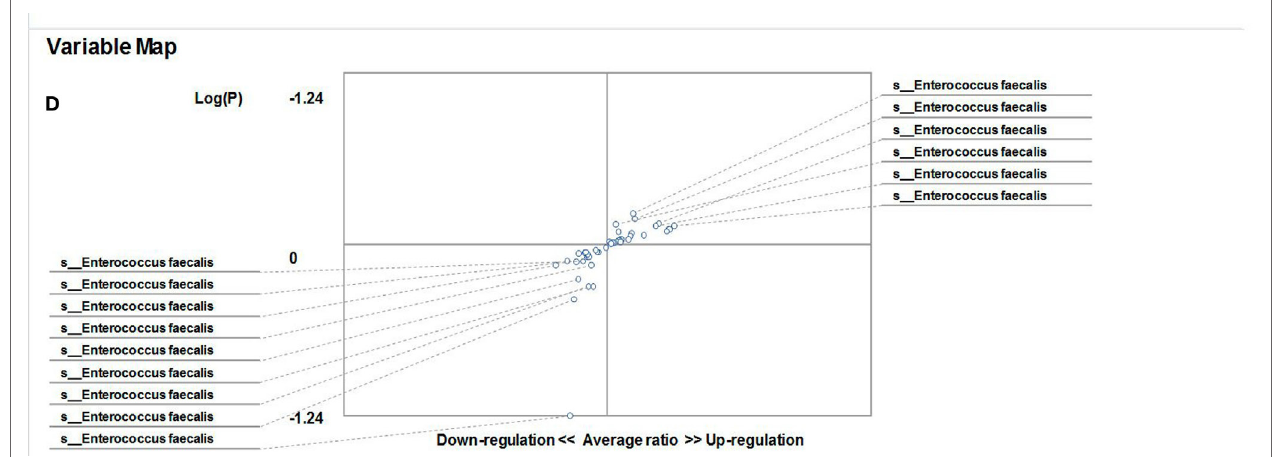
FigUre 5 | Distribution of gut Enterococcus faecalis in familial Mediterranean fever (FMF) men. Contribution of variables to differentiation between two groups [ X axis, average ratio between two groups; Y axis, − Log (P)]. The upper-right and lower-left corner are the most significant. (a) FMF men with Candida albicans below baseline level/healthy men; (b) FMF men with gut C. albicans numbers above baseline level after probiotic therapy/healthy men; (c) FMF men with gut C. albicans numbers above baseline level/Healthy men; (D) FMF men with gut C. albicans numbers above baseline level before probiotic therapy/FMF men with gut C. albicans numbers above baseline level after probiotic